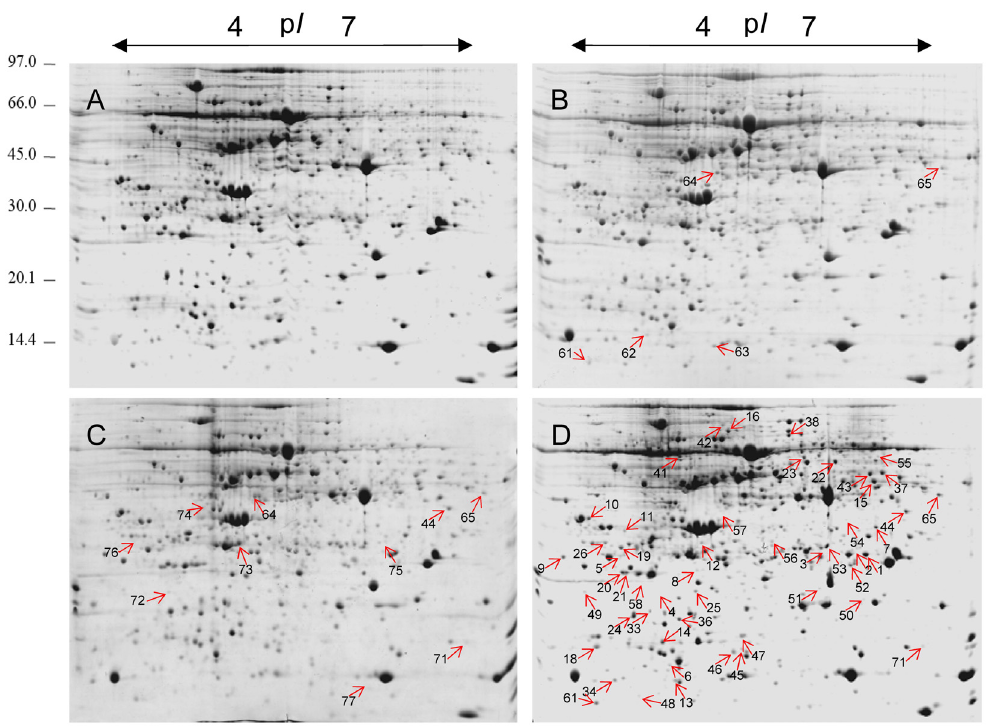
Figure 4. Representative images of 2-DE gels. Total leaf proteins were extracted and separated by 2-DE. Proteins (1200 µg) were separated in the first dimension on immobilized pH 4–7 pH dry strips (24 cm, linear) and in the second dimension on a 12.5% SDS-PAGE gel. The gel shown was stained with CBB-R250. Labeled spots indicate differentially expressed proteins showing at least a 1.5-fold change under Cr(VI) treatments, with p < 0.05. ( A ) 2-DE gel of control (0 h); ( B ) 2-DE gel of sample collected at the time-point 1 h; ( C ) 2-DE gel of sample collected at the time-point 6 h; ( D ) 2-DE gel of sample collected at the time-point 24